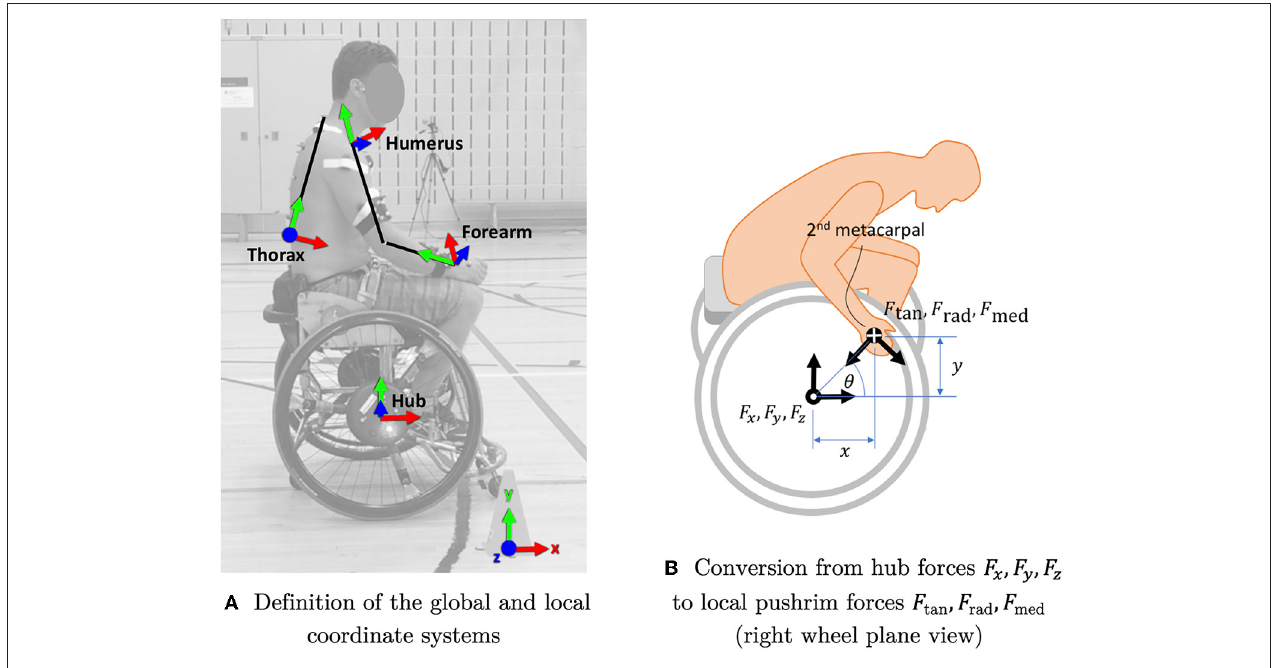
FIGURE 1 | (A,B) Coordinate system